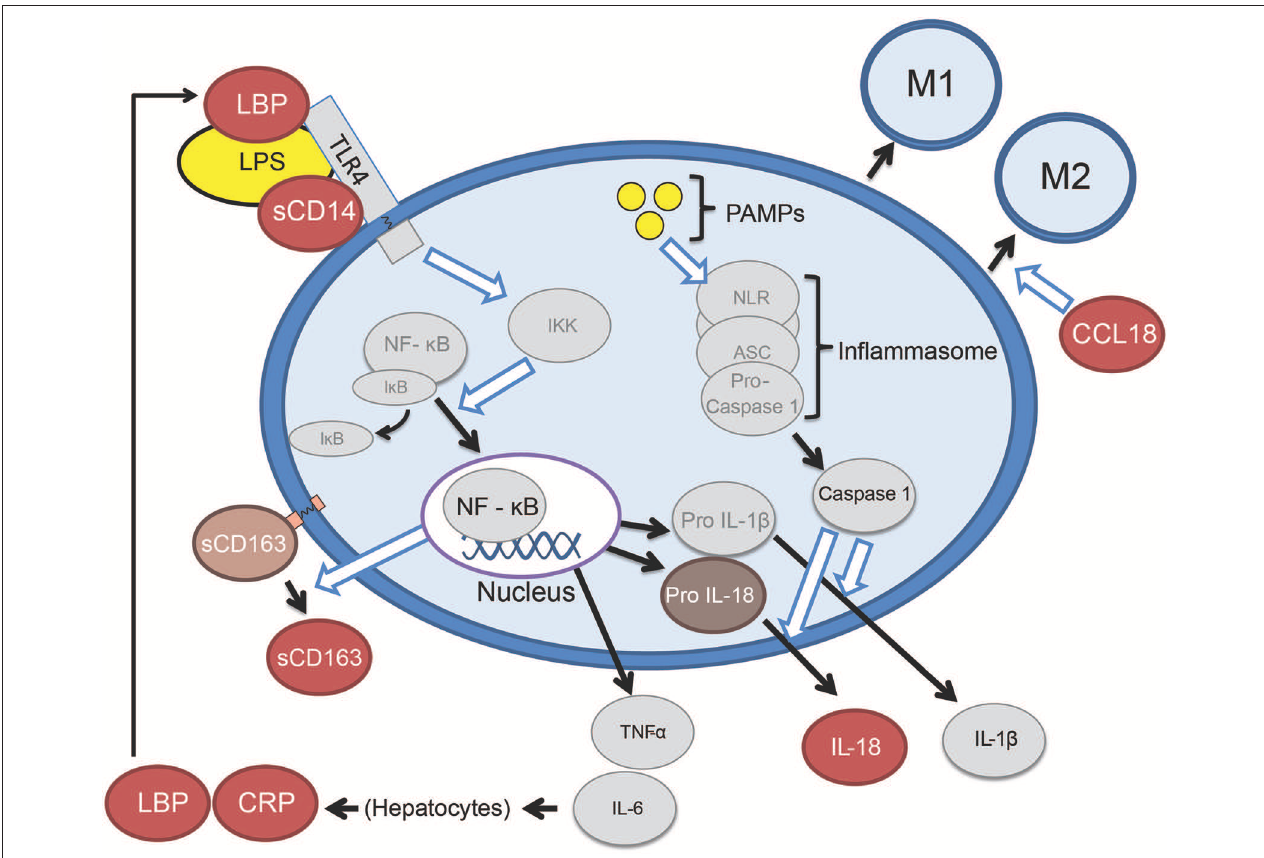
FIGURE 1 | Abbreviated summary of monocyte activation pathways. Proteins depicted as red ovals were selected as candidate markers of monocyte activation. Bacterial lipopolysaccharide (LPS) requires the presence of LBP (lipopolysaccharide binding protein) and sCD14 (soluble cluster of differentiation 14), to TLR4 (toll-like receptor 4) and the NF- κ B (nuclear factor kappa-light-chain-enhancer of activated B cells) ( 8). Activating monocytes cleave surface CD163 (Cluster of Differentiation 163) in to a soluble form (sCD163) (9). Monocytes may also be activated by pathogen-associated molecular patterns (PAMPS) which lead to release IL-18 via the inflammasome pathway (10). Classical monocytes (CD14 + , CD16 − ) eventually transition to intermediate (CD14 + CD16 + ) and eventually non-classical monocytes (CD14 low , CD16 + ) (11), the latter of which are a source of CCL18 (chemokine C-C motif ligand 18)